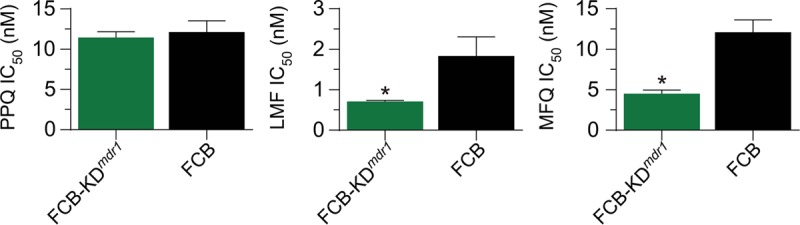
In vitro drug susceptibility profiles of the FCB-KDmdr1 and FCB lines. Shown are the mean ± SEM IC50s of the pfmdr1 knockdown FCB-KDmdr1 and its parental FCB line to piperaquine (PPQ [left panel]), lumefantrine (LMF [middle panel]), and mefloquine (MFQ [right panel]). IC50s were determined in 72-h assays as per Fig. 3. Statistical comparisons of the FCB-KDmdr1 line to its nonrecombinant parental FCB line were made using two-tailed Mann-Whitney U tests. *, P < 0.05.